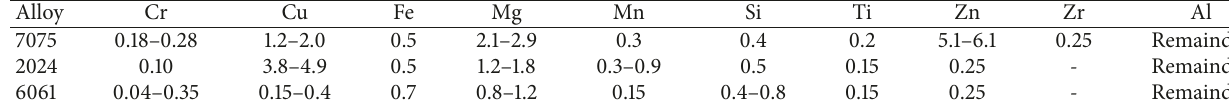
Table 1: Percentage composition of the studied Al alloys.